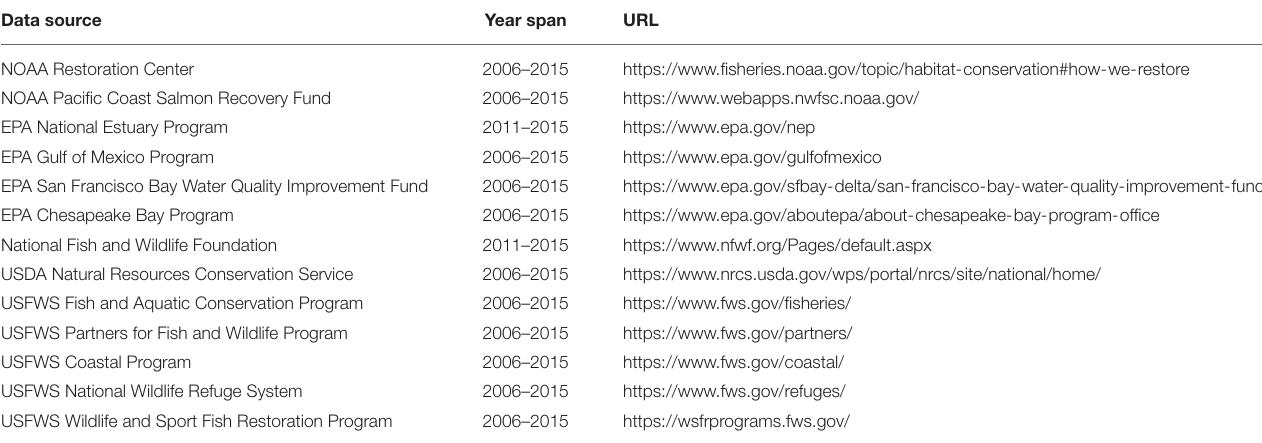
TABLE 2 | SNAPP restoration data